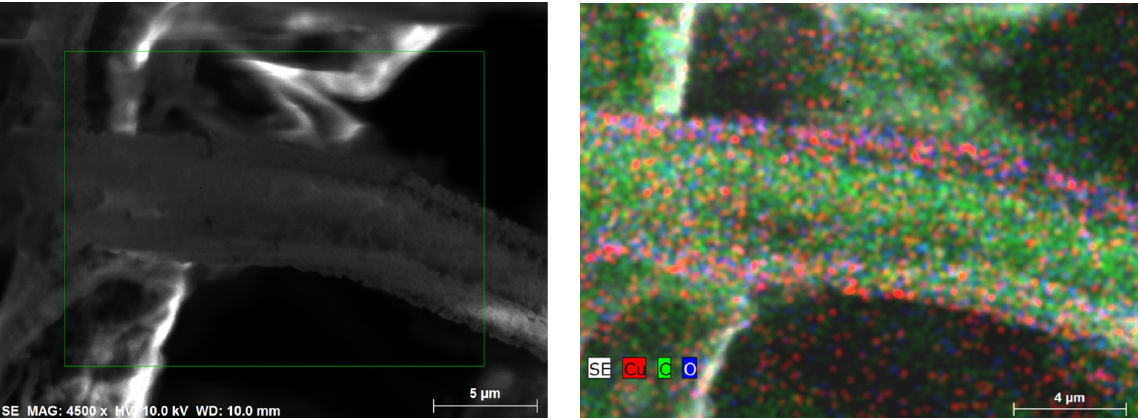
Figure 6. Cu particle distribution on mask surface. SEM images of the middle mask layer on the left. EDS elemental mapping showing Cu particles distribution on the right.